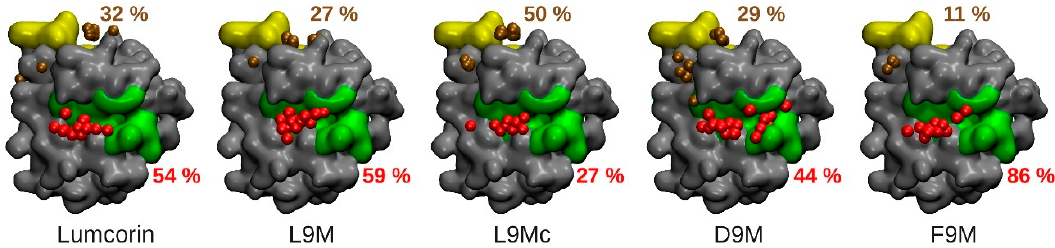
Figure 4. Anchoring of peptides on catalytic and MT-Loop regions. From left to right, localization of lumcorin, L9M, L9Mc, D9M, and F9M peptides on the MMP-14 surface. Two regions of the MMP-14 proteins are prone to interactions: the catalytic region, depicted in green, and the MT-Loop region depicted in yellow. Spheres are used to place the center of mass of the 100 best solutions and the color code indicates their localization at the surface of MMP-14: red spheres are in the catalytic region and spheres in brown are in the vicinity of the MT-Loop. The colored numbers indicate the percentages of solutions associated with each region.